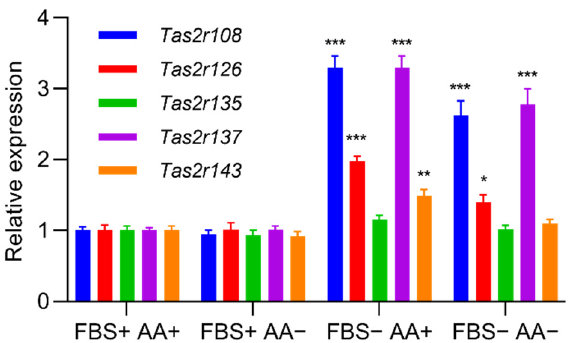
Figure 2. Deprivation of serum increased the expression of Tas2r genes in 3T3-L1 adipocytes. The 3T3-L1 adipocytes were cultured in the medium with (+) or without ( − ) fetal bovine serum (FBS) and amino acids (AA) for 1 h. Tas2r expression was determined by RT-qPCR analysis. Actb was used as the reference gene. N = 6, * p < 0.05 , ** p < 0.01, *** p < 0.001 (vs. FBS+AA+, Dunnett test).